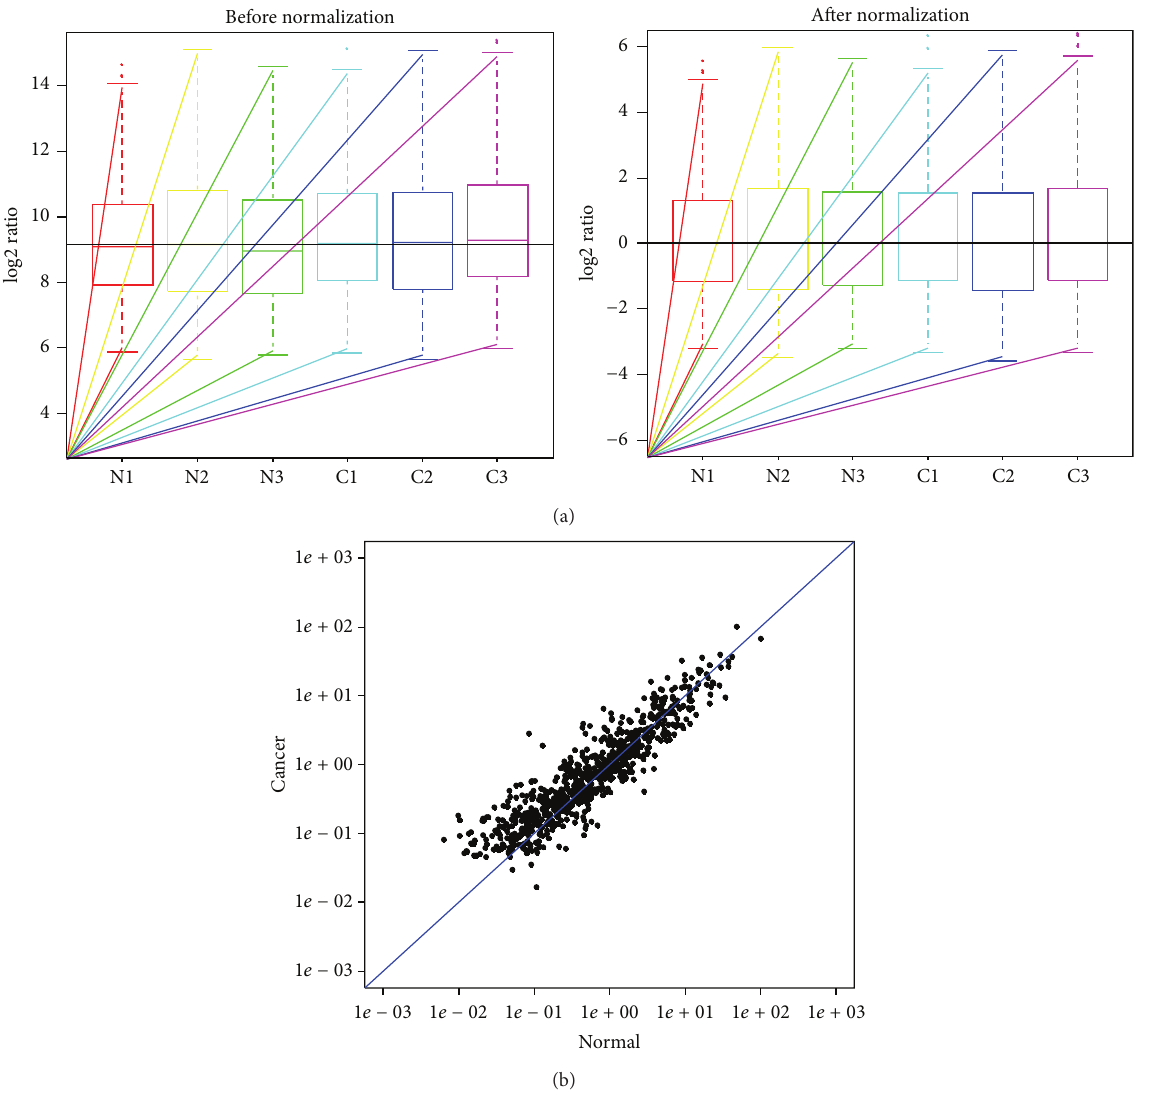
Figure 1: (a) The box plots are used to compare distributions of samples (left: nonnormalized log2-ratio data; right: median normalized log2- ratio data). (b) The scatter-plots assess the variation of miRNAs expression between cancerous and normal tissues. The axes of the scatter-plot are the normalized signal values of the samples (ratio